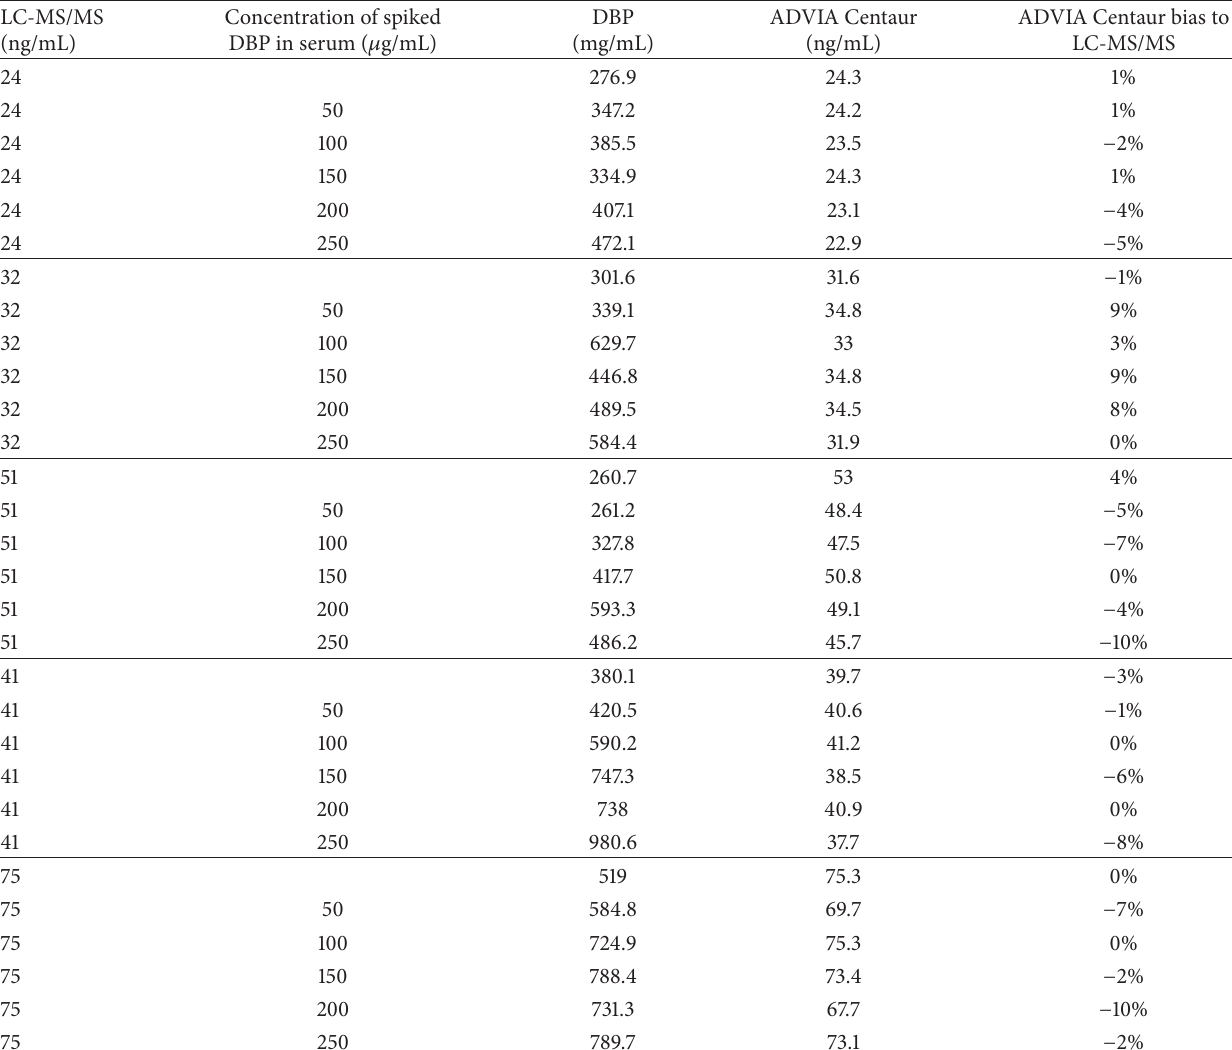
Table 3: Serum concentrations of DBP in healthy subjects and DBP-spiked samples from healthy